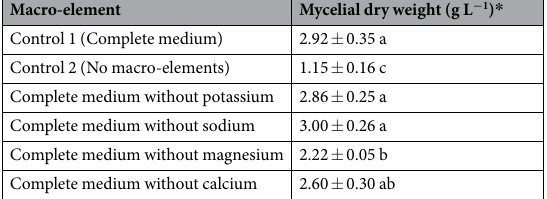
Table 9. Effects of macro-element on the mycelial growth of Isaria farinosa . * Mean ± SE. Values followed by the same letters within a column do not differ significantly (ANOVA, P =